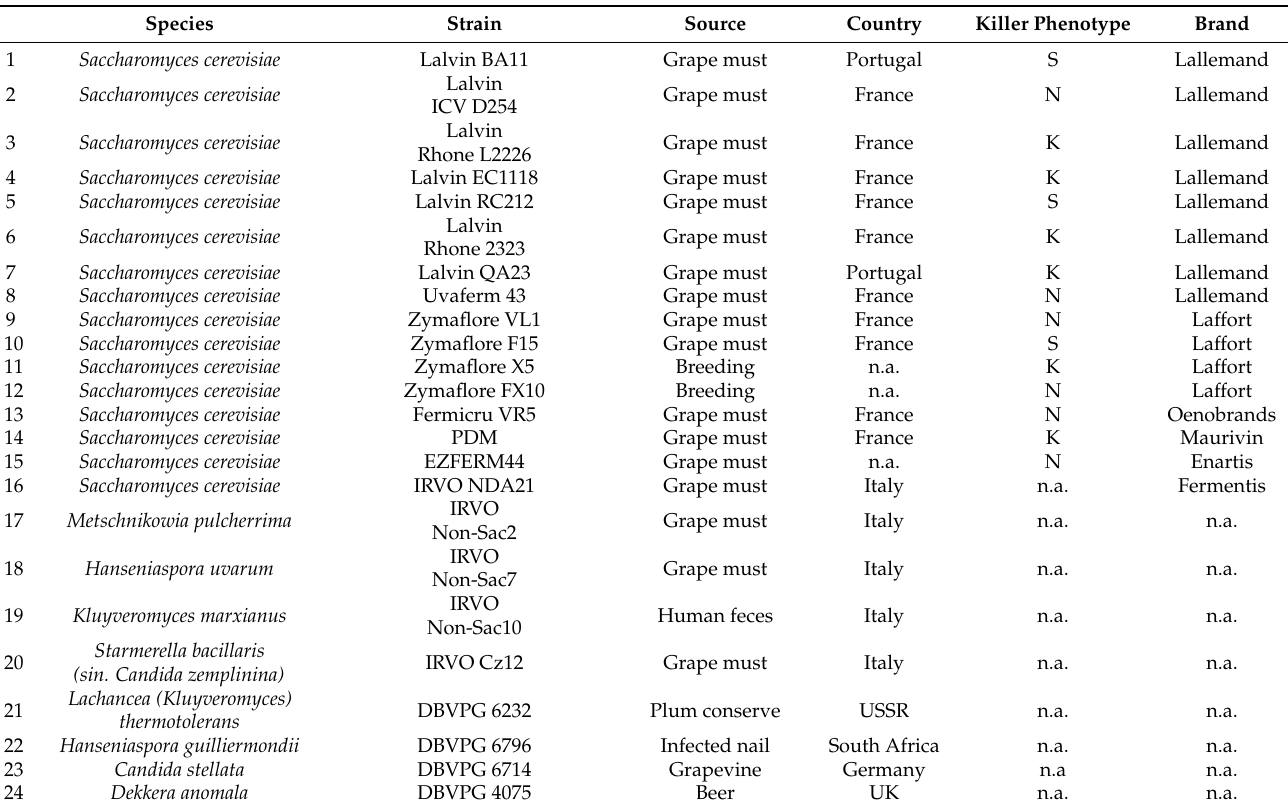
Table 1. Listofyeaststrainsusedinthisstudy.